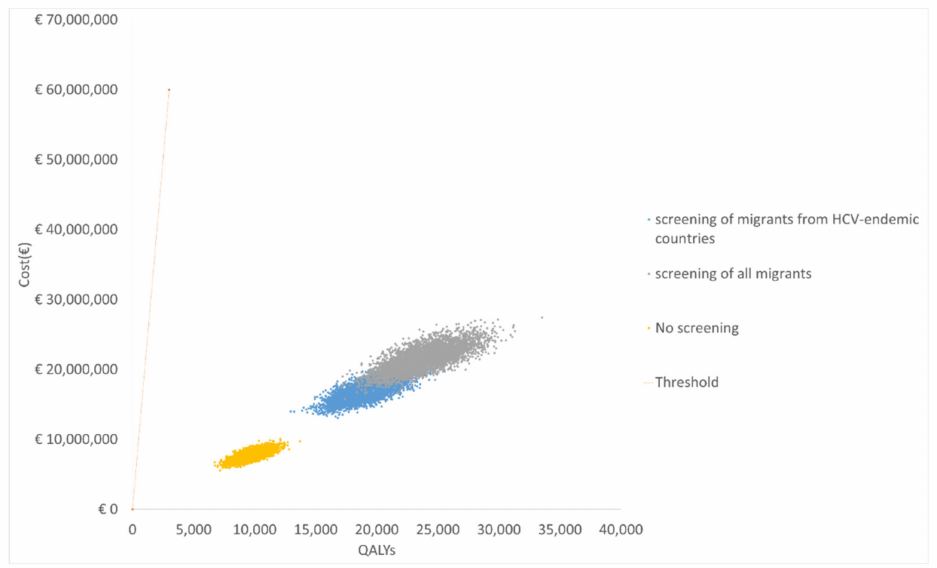
Figure 4. Cost-e ff ectiveness